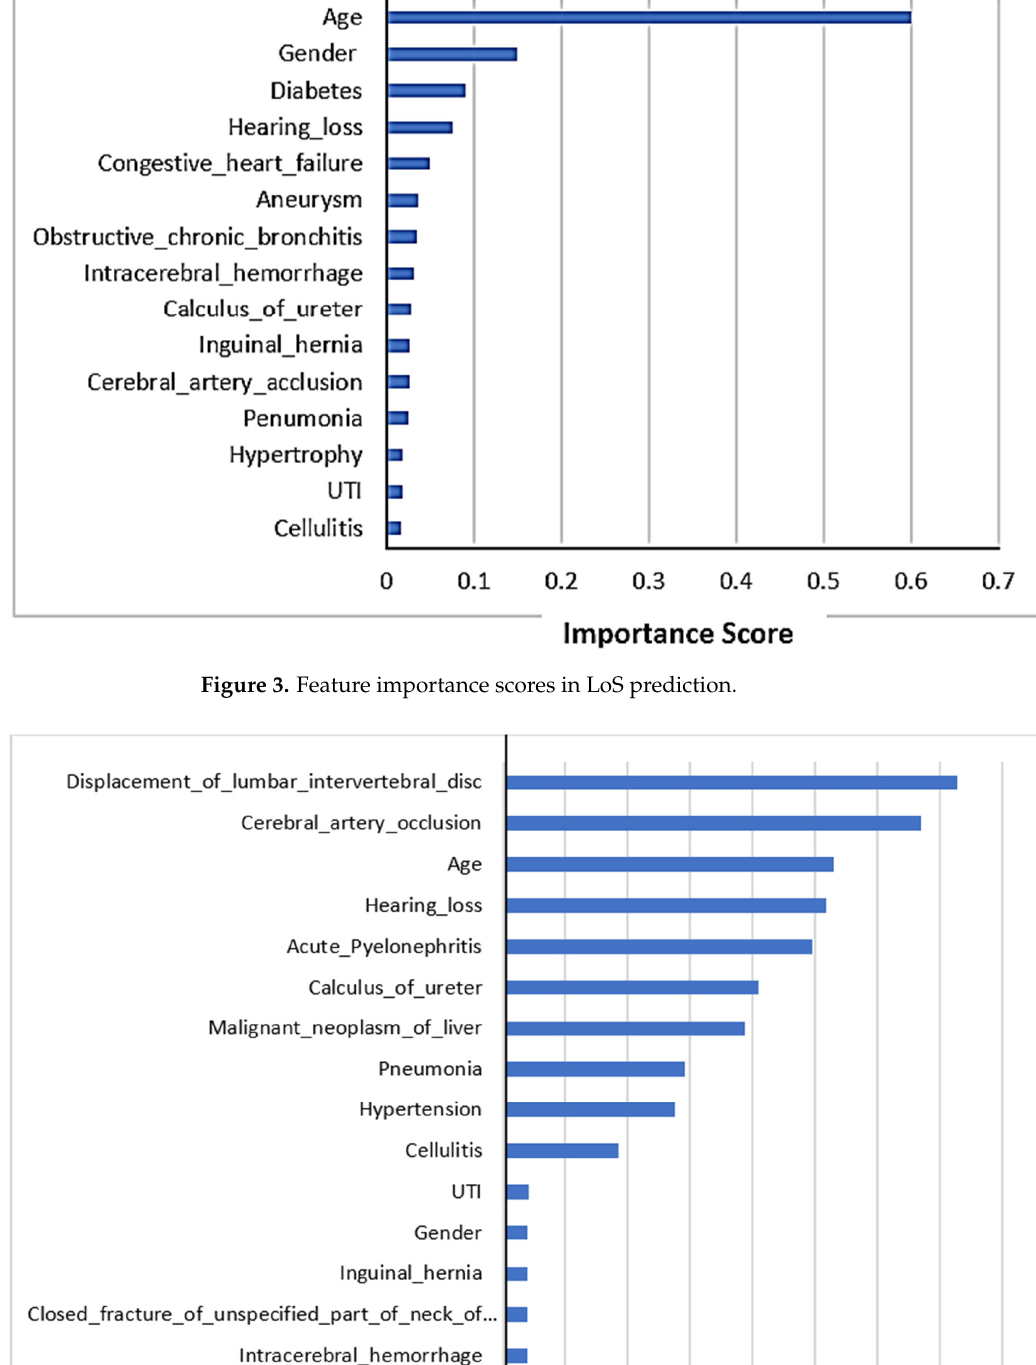
Table 5. Excluded models based on overfitting or accuracy.